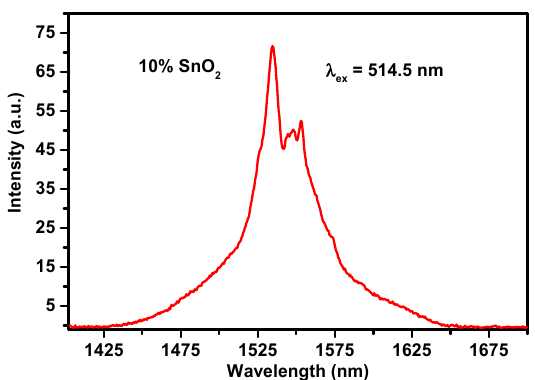
Figure 4. Emission spectrum of 90SiO 2 -10SnO 2 :0.5Er 3+ monolith heat-treated at 900 ◦ C for 40 h excited at 514.5 nm by using an Ar + laser as an excitation